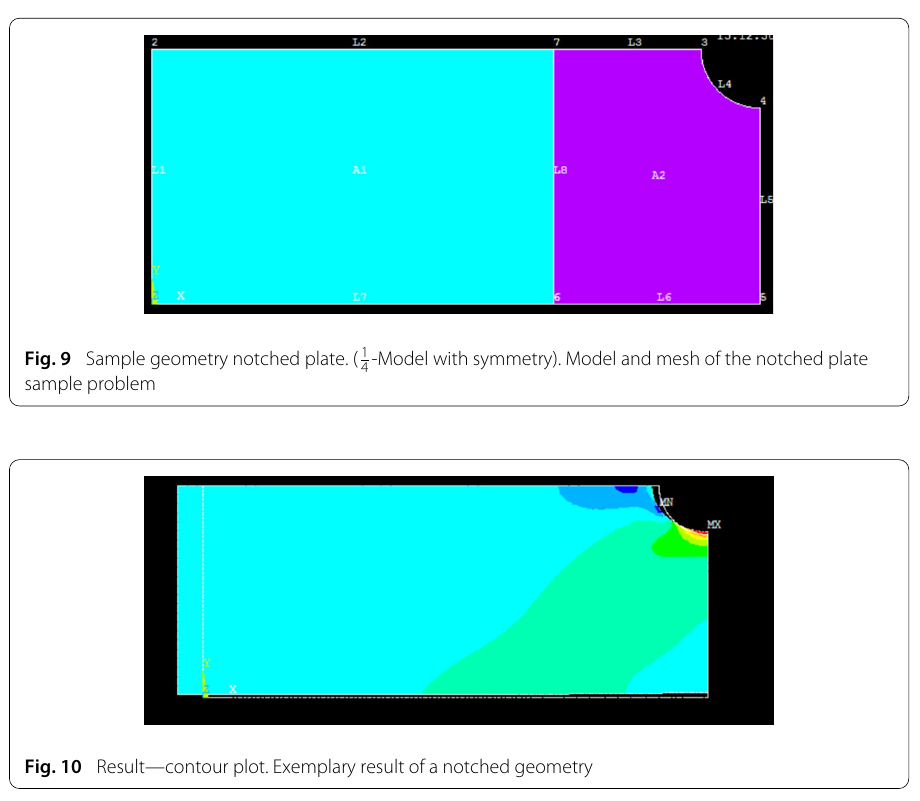
Fig. 10 Result—contour plot. Exemplary result of a notched geometry